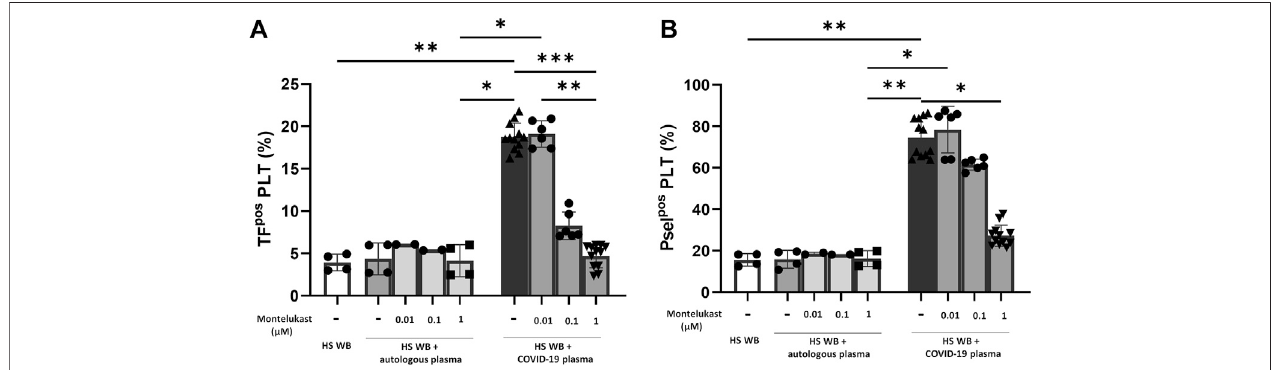
FIGURE 1 | In vitro effect of montelukast on platelet-associated tissue factor (A) and P-selectin (B) expression induced by COVID-19 plasma. Whole blood (WB) fromhealthysubjects(HS; n =4),pre-incubatedwithmontelukast(0.01 – 1 µM),wasplasma-depletedandreconstitutedwithCOVID-19plasmapools( n =3foreachHS, dark gray bars) or autologous plasma (light gray bars). The percentage of TF pos - and P-selectin pos -platelets was assessed by fl ow cytometry. Data are reported as mean ± SD. * p < 0.05; ** p < 0.01; *** p < 0.001 (TF, tissue factor; Psel, P-selectin; PLT, platelets).